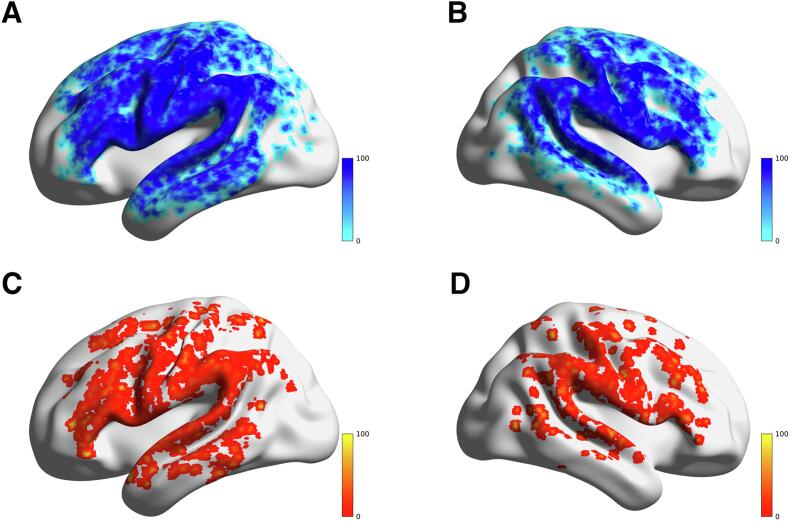
Percentages of voxel-wise rTMS stimulations of all patients in MNI space: (A) Left negative spots. (B) Right negative spots. (C) Left positive spots. (D) Right positive spots. The numbers and the color bar indicate the percentages of rTMS positive or negative stimulations per voxel.